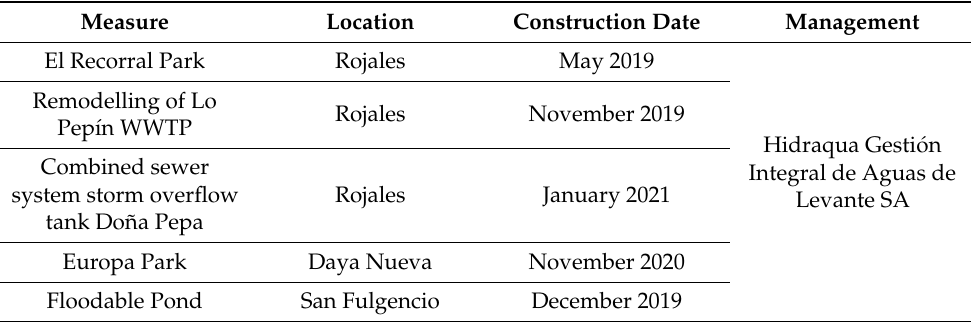
Table 1. Flood risk adaptation measures implemented in the case